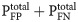
Sorting accuracy.Comparison of the true rate of misclassified spikes (FPrate + FNrate) between the consensus-based clustering method and a quadratic support vector machine trained on the ground truth data (SVM, see Methods). Each dot corresponds to the rate of misclassification for the single unit matching the ground truth cell spike times. Symbols and colors correspond to different experiments. A few cells could not be identified correctly and showed much higher rates of misclassification than the optimal performances reached by the SVM classifier. Nevertheless, these clusters (circled symbols) were not validated as well isolated single units because their signal-to-noise ratio (SNR) was too low (SNR < 4) or their estimated rates of misclassified spikes (PFPtotal+PFNtotal, see Methods) were higher than 20%.